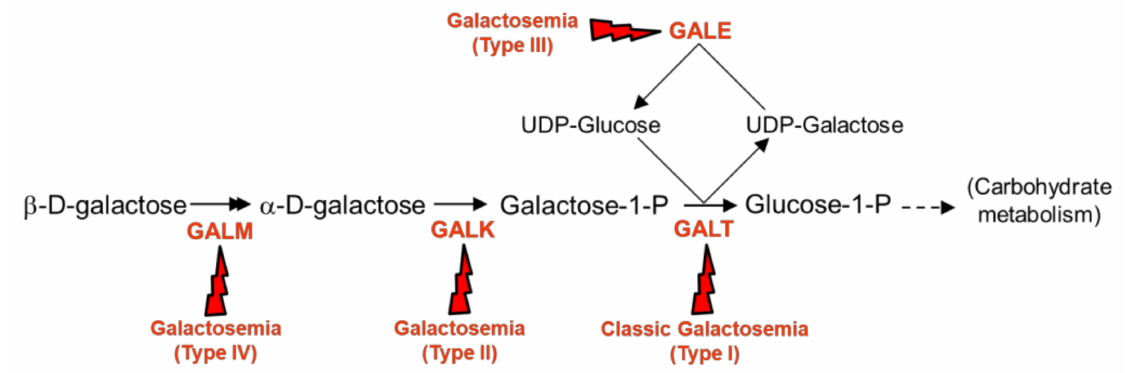
Scheme 1. Leloir pathway of galactose metabolism. The enzymes catalyzing the different steps are galactose mutarotase (GALM), galactokinase 1 (GALK), galactose-1-phosphate uridylyltransferase (GALT) and UDP-galactose 4-epimerase (GALE). Different forms of galactosemia derive from the impairment of each enzyme, as represented in the